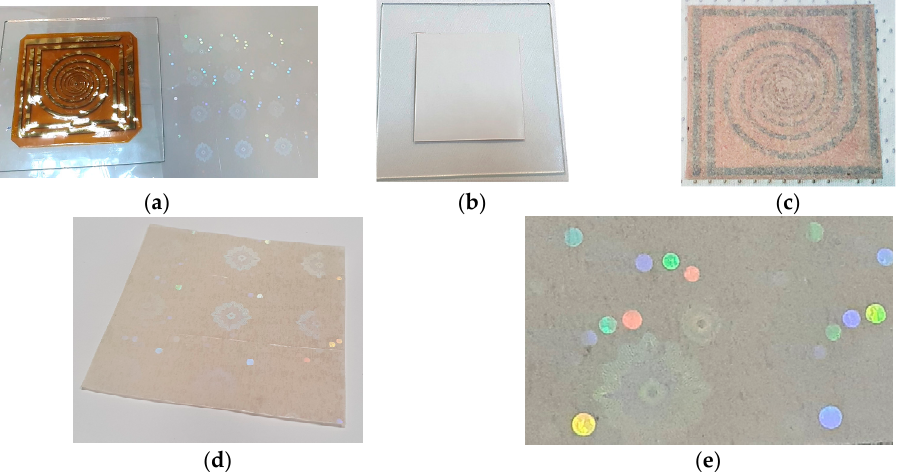
Figure 11. Integration stage: ( a ) antenna con fi gured on kapton substrate with passive RFID chip and holographic foil; ( b ) layer a tt achment to increase the visual e ff ect of the holographic elements; ( c ) intelligent multilayer hologram backside with adhesive and protective silicone paper; ( d ) multilayer intelligent hologram frontside; and ( e ) detail.